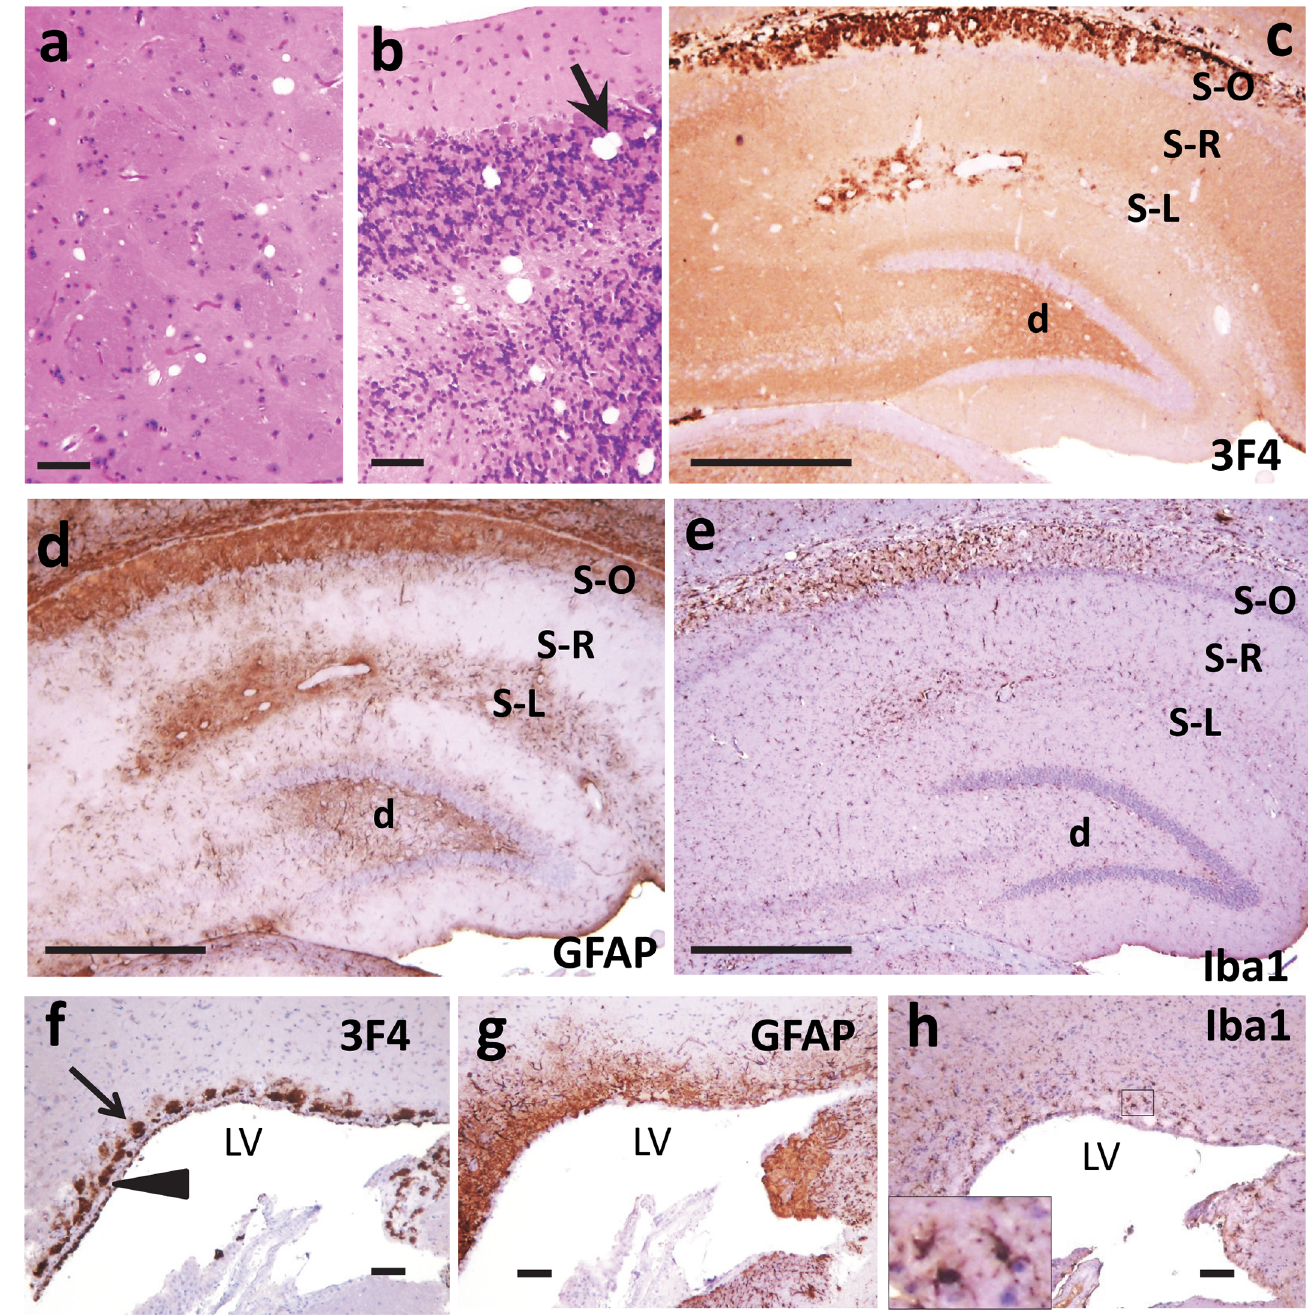
Fig 4. Histopathological analysis of brains from the 2 nd passage of PrPres produced in dgPMCAb reactions seeded with fibrillar WT α - synuclein. Representative images of caudate putamen( a ) and cerebellum( b ) stained with hematoxylinand eosin, hippocampus stainedwith anti-PrP 3F4 ( c ), anti-GFAP ( d ) or anti-Iba1 antibody ( e ), or subventricular zones stained with anti-PrP 3F4 ( f ), anti-GFAP ( g ) or anti-Iba1 antibody( h) . Subventriculardepositsare indicatedby arrows and the ventricular surface of ependymal cells is indicatedby an arrowhead. S-O, stratum oriens; S-R, stratum radiatum; S-L, stratum lacunosum-moleculare;d, dentate gyrus, LV, lateral ventricle. Scale bars: in a, b, f, g, h = 100 μ m, c, d, e = 500 μ m.